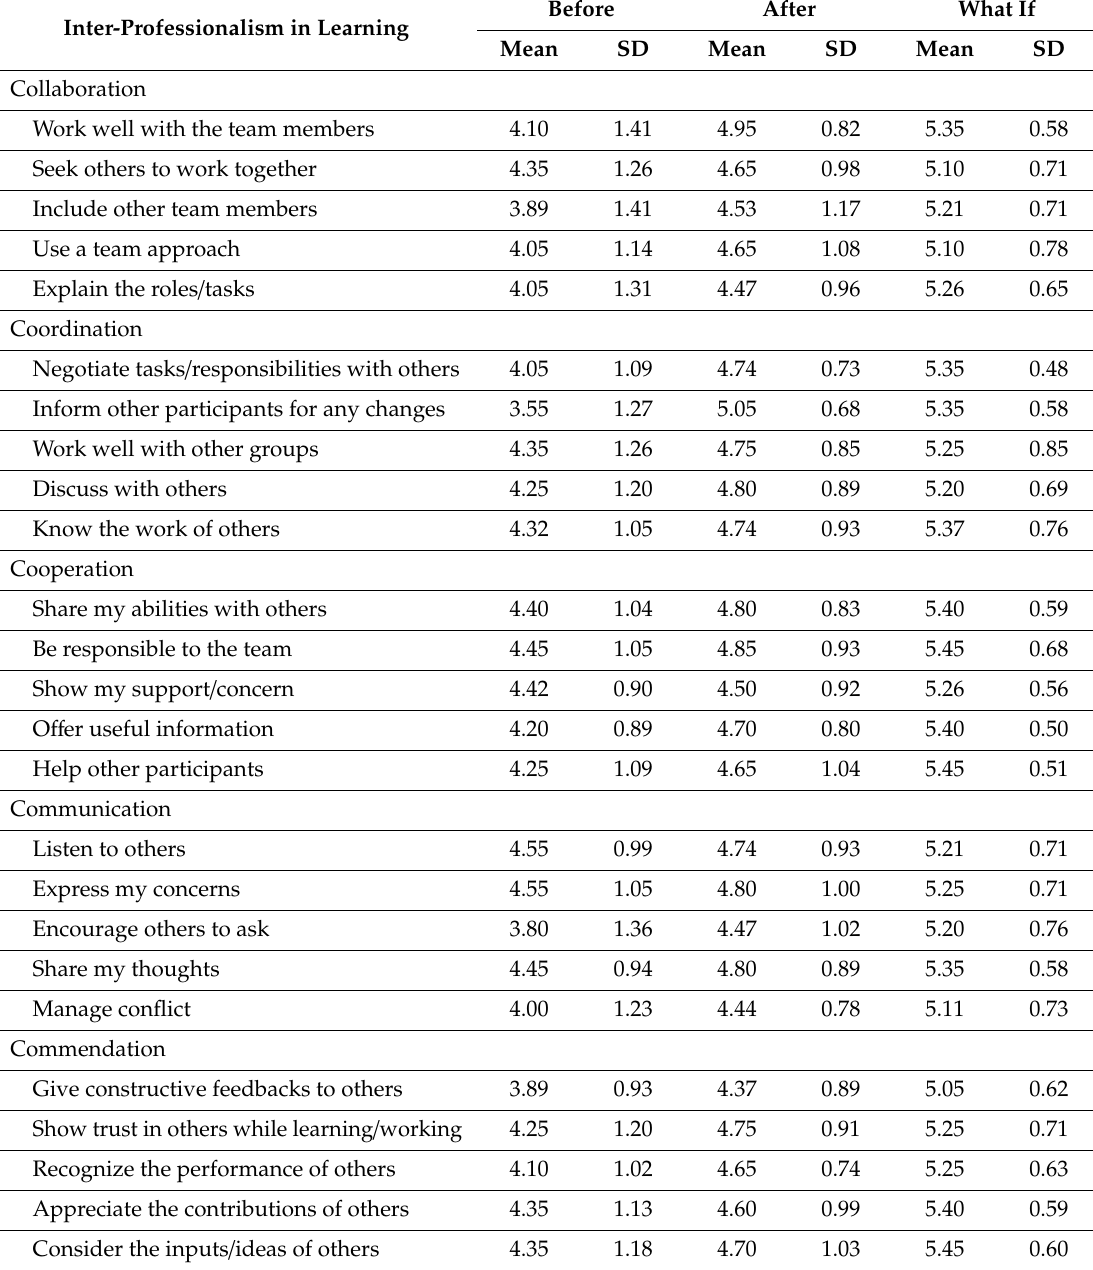
Table 3. Inventory of Reflective Vignette (IRV)-IPL test responses ( n =